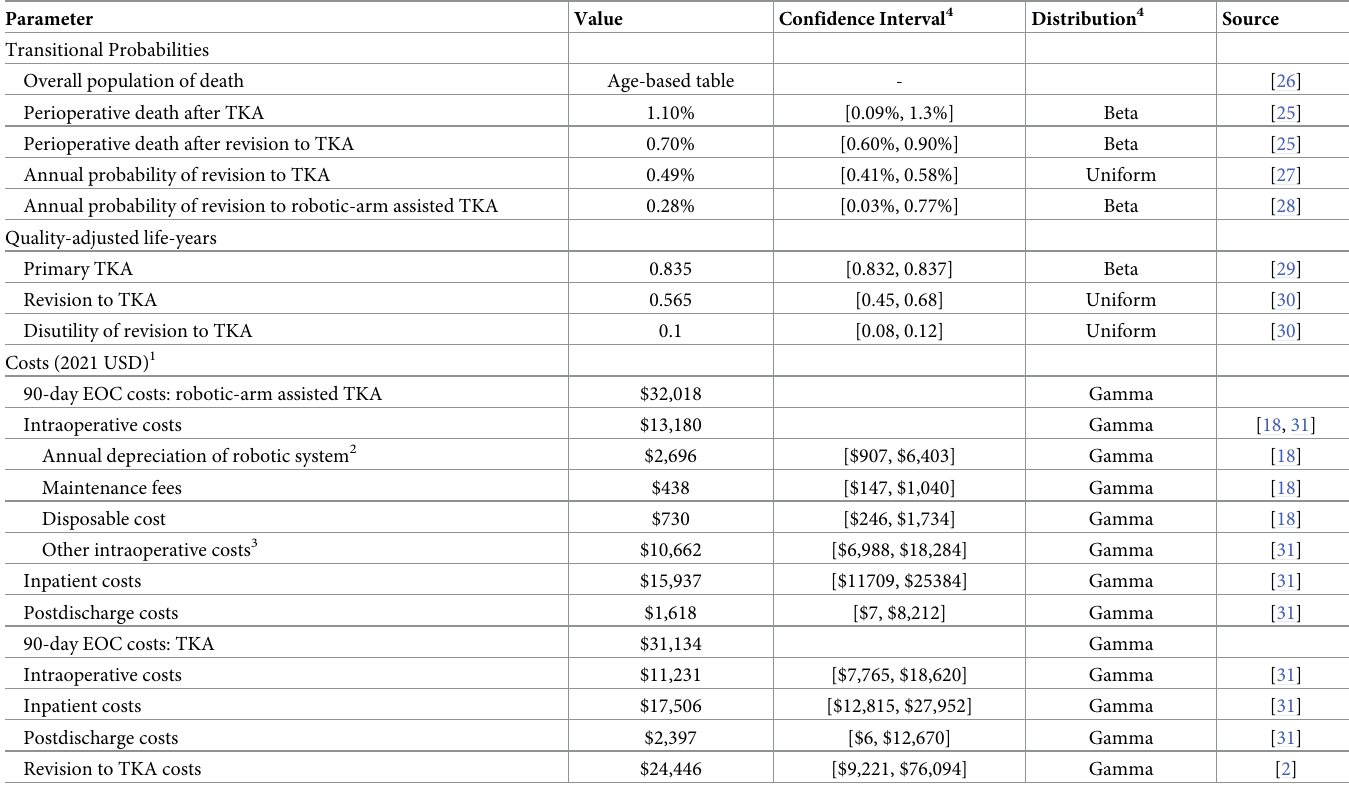
Table 1. Model input parameters.